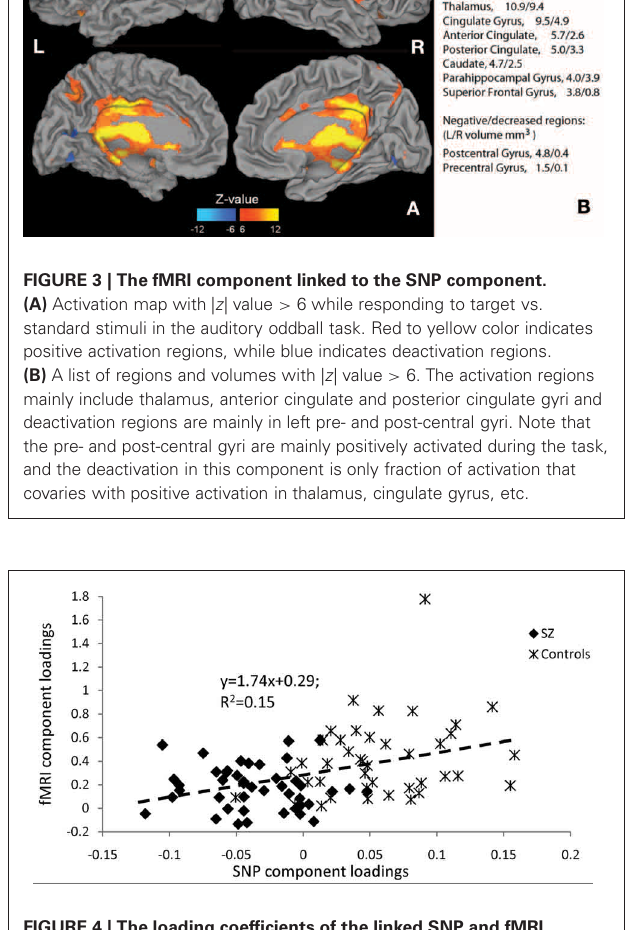
FIGURE 4 | The loading coefficients of the linked SNP and fMRI components. The X and Y axis are the loadings for SNP and fMRI components, respectively. The positive trend shows the positive correlation ( r = 0 . 39, R 2 = 0 . 15) between these linked components. Healthy controls demonstrates strong positive presence of the SNP component and higher activation in the fMRI component, while schizophrenia patients carry negative presence of the SNP component (opposite combination of minor alleles in the SNPs), and lower activation in the fMRI